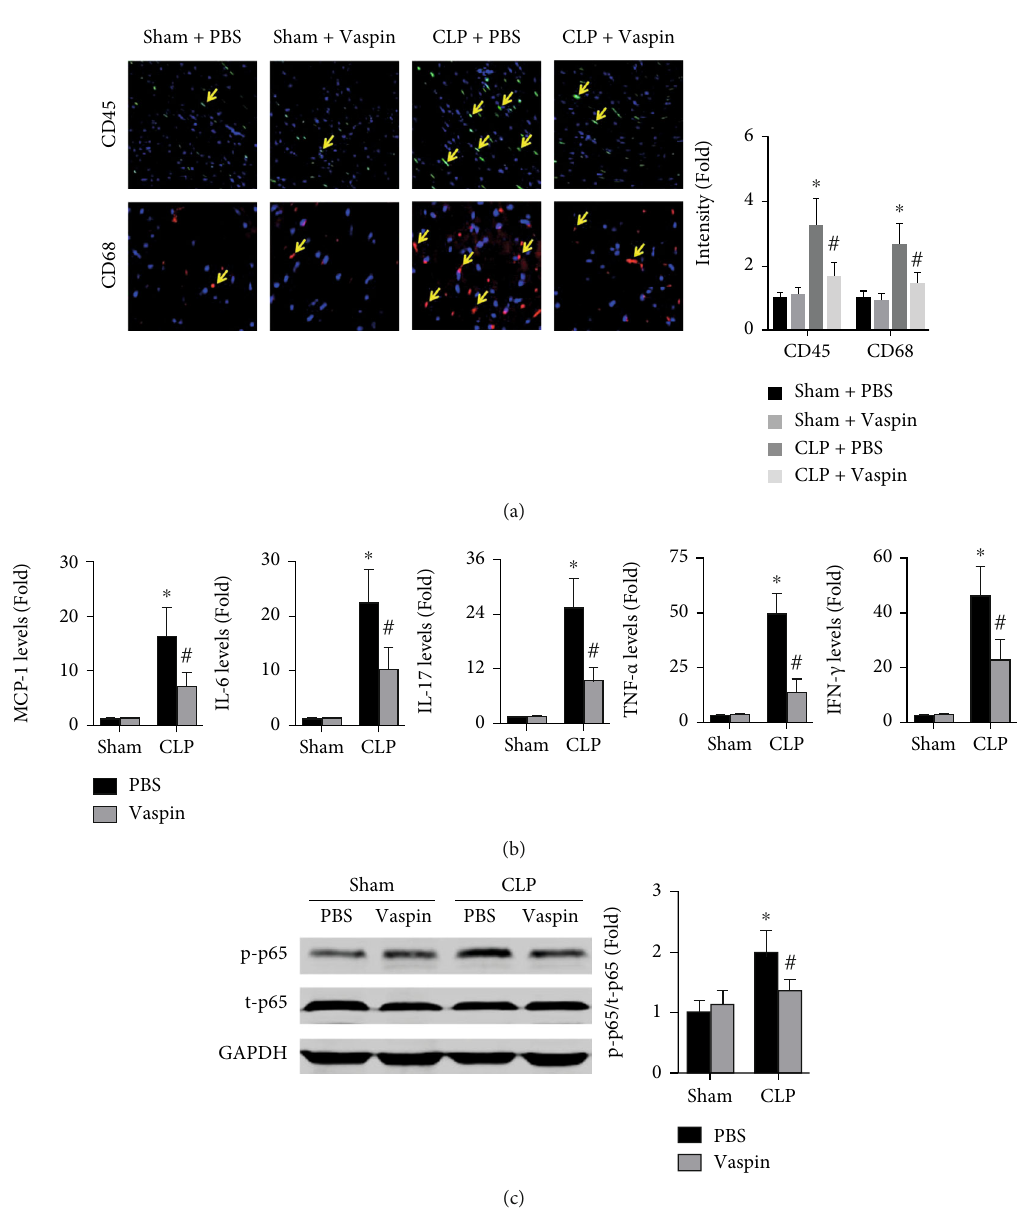
Figure 4: E ff ects of vaspin on sepsis-induced cardiac in fl ammation in mice. (a) Cardiac CD45+ cells and CD68+ cells in each group were examined (two-way ANOVA). (b) Cardiac mRNA expression levels of MCP-1, IL-6, IL-17, TNF- α , and IFN- γ were measured (two-way ANOVA). (c) The phosphorylation of NF- κ B p65 in each group (two-way ANOVA). Blue, green, and red indicate nuclei, CD45-positive cells, and CD68-positive cells, respectively. N = 5 in each group. ∗ p < 0 : 05 vs. the sham + PBS group. # p < 0 : 05 vs. the CLP + PBS